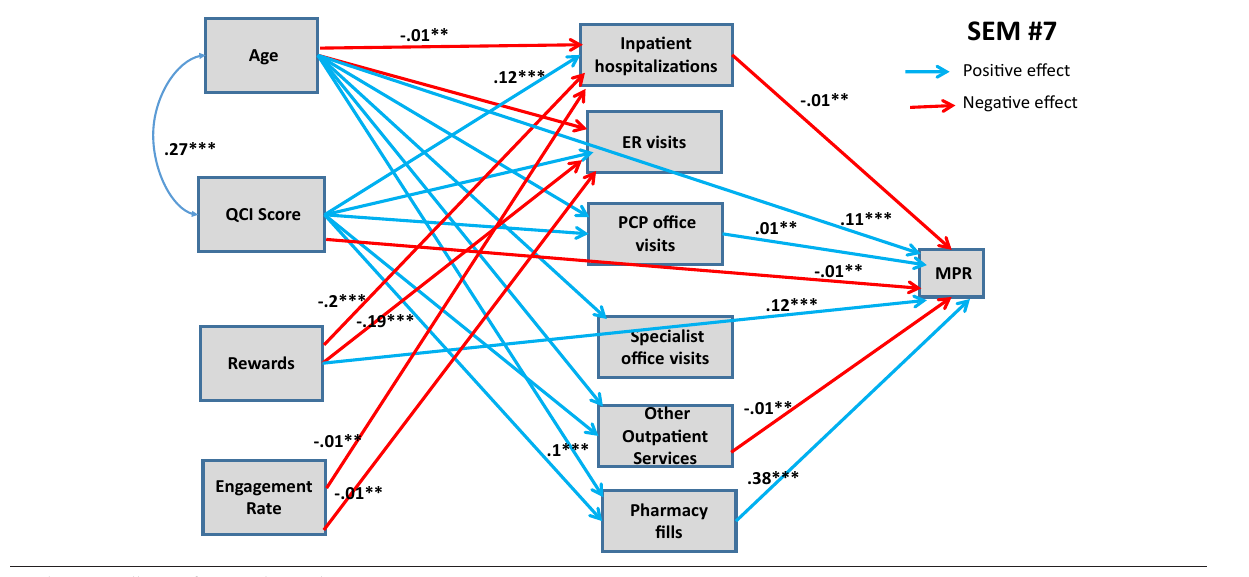
Figure 3. SEM #7 Presents Structural Determinants of MPR from HIRD Data and TRUSTR Social Media Experimental Data